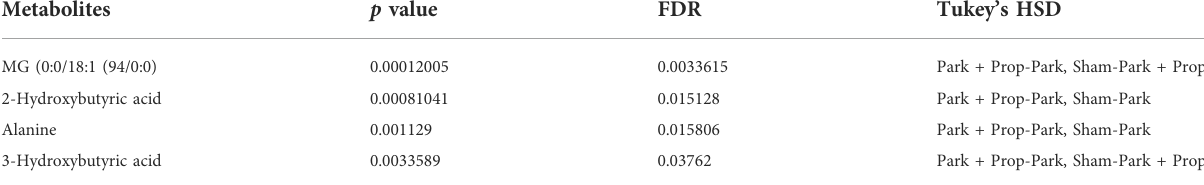
TABLE 2 Table with metabolites with statistically signi fi cant difference within groups, indicated by Tukey ’ s HSD test. Metabolites p value FDR Tukey ’ s HSD